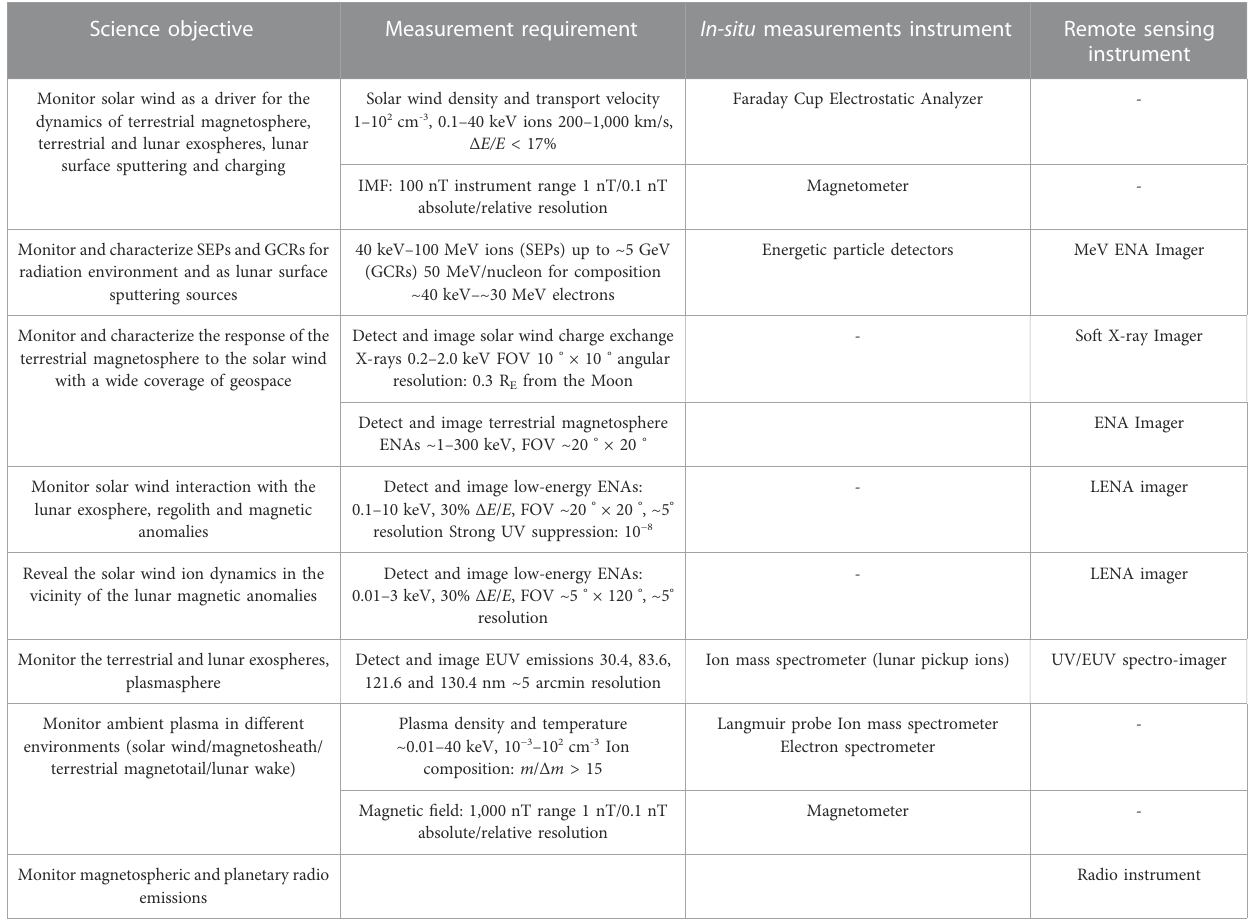
TABLE 4 Science objectives and corresponding measurement and instrumentation requirements (from onboard the